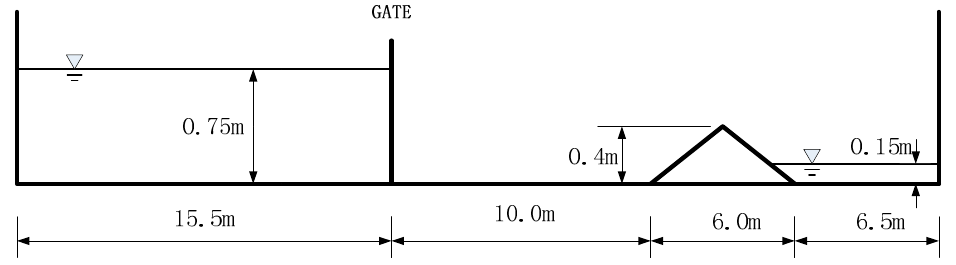
Figure 1. Schematic layout of dam break flow experiment with a triangular hump [19].